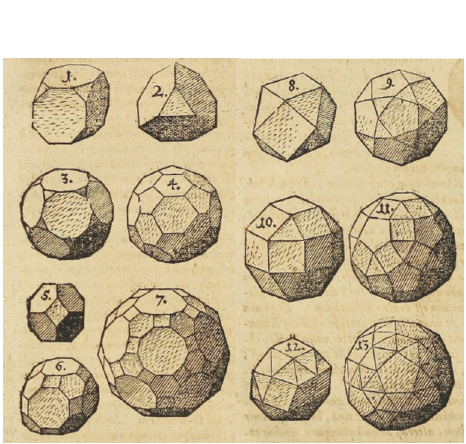
Fig. 3. Platonic solids (J. Kepler, Harmonices Mundi , 1619)